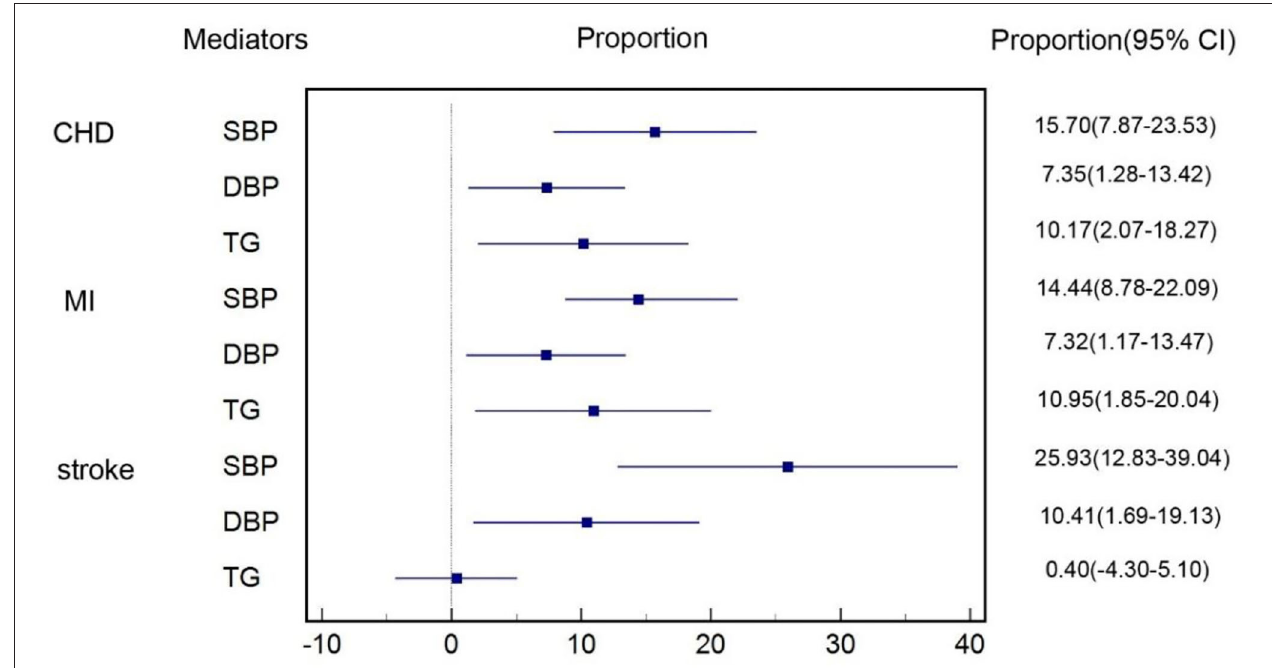
FIGURE 4 | Proportion of the effect of T2DM on each subtype of CVD mediated by cardiometabolic